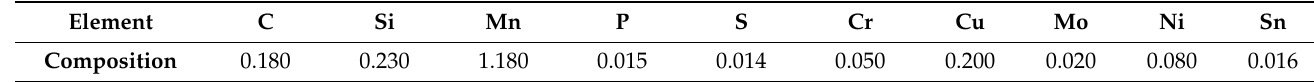
Table 9. Chemical composition of E235 steel (wt